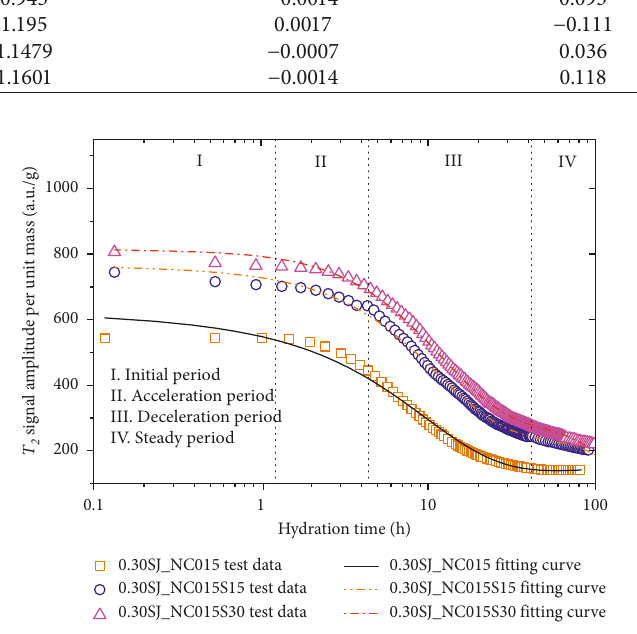
Figure 9: Experiment data and fitting curves of cement pastes with different SAP dosages. Table 9: Fitting parameters and correlation of cement pastes with different SAP